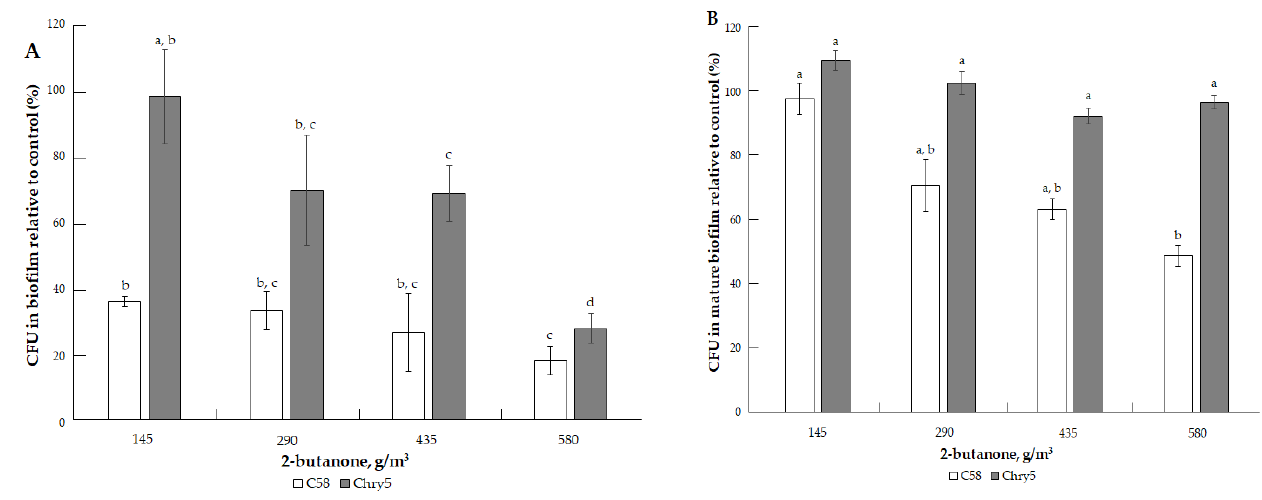
Figure 3. The effect of 2-pentanone on the formation of biofilm of A. tumefaciens C58 (white column) and Chry5 (gray column) ( A ) and cell survival in mature biofilms ( B ) depending on the concentra- tion of 2-pentanone. CFU of bacteria strains in the control (without VOC): 100 a %. The different lowercase letters above the mean values indicate significant differences ( p ≤ 0.05; Tukey’s HSD test).